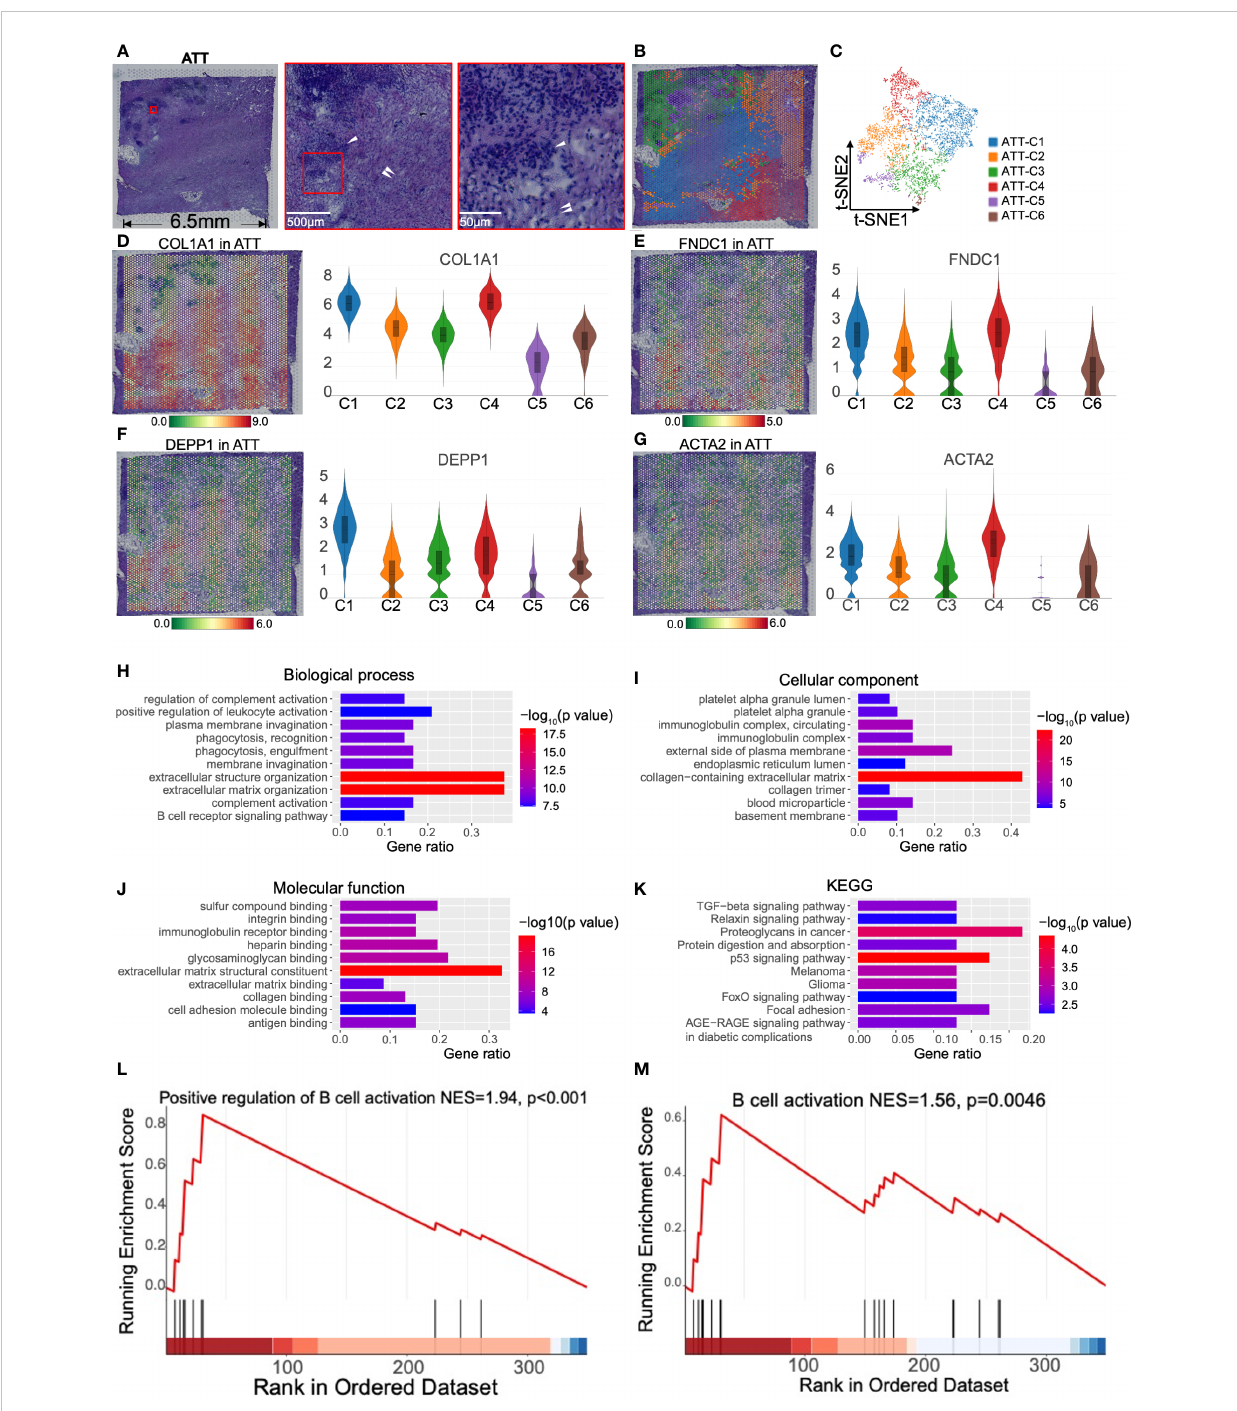
FIGURE 3 Clustering and spatial distribution of the spots from adjacent tumor tissue (ATT). (A) Hematoxylin and eosin stained images of ATT. The red box shows islets (white single arrow) and stromal tissue (white double arrow). The lower right is adjacent to the tumor, and the upper left is near the normal pancreas. (B) The spots were grouped into six clusters and distributed to the ATT compartment. (C) t-SNE plot of the six clusters. The level and distribution of COL1A1 (D) , FNDC1 (E) , DEPP1 (F) , and ACTA2 (G) in ATT. Gene Ontology enrichment analysis of the top 50 genes of ATT-C4, including biological process (H) , cellular component (I) , and molecular function (J) . (K) Kyoto Encyclopedia of Gene and Genomes (KEGG) pathway enrichment analysis of ATT-C4. (L, M) Gene set enrichment analysis shows that ATT-C4 genes are signi fi cantly associated with B cell activation. The bar plots and the vertical coordinate of the violin plots indicates the log 2 FC of the gene expression value of each cluster versus the average gene